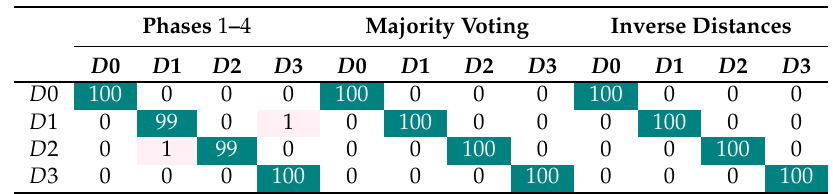
Table 6. Confusion matrix of the application of the t -SNE based damage detection and classification procedure presented in Sections 3 and 4 to the case of the aluminum plate in Scenario 3 , when the four actuation phases are used at the same time, in the frequency domain . Rows represent true values, while columns represent predicted